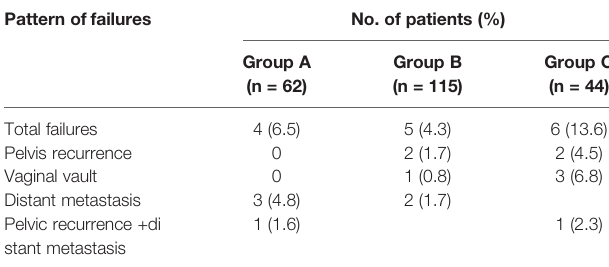
TABLE 2 | Incidence and pattern of cervical cancer failures in the three groups.